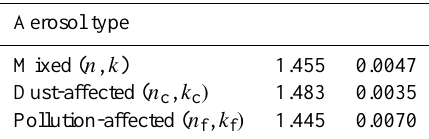
Table 1. Real ( n ) and imaginary ( k ) refractive index values at 532nm used in the Mie simulations for mixed aerosol loads and for aerosol loads significantly affected by desert-dust intrusions ( n c , k c ) and continental pollution ( n f , k f ) .